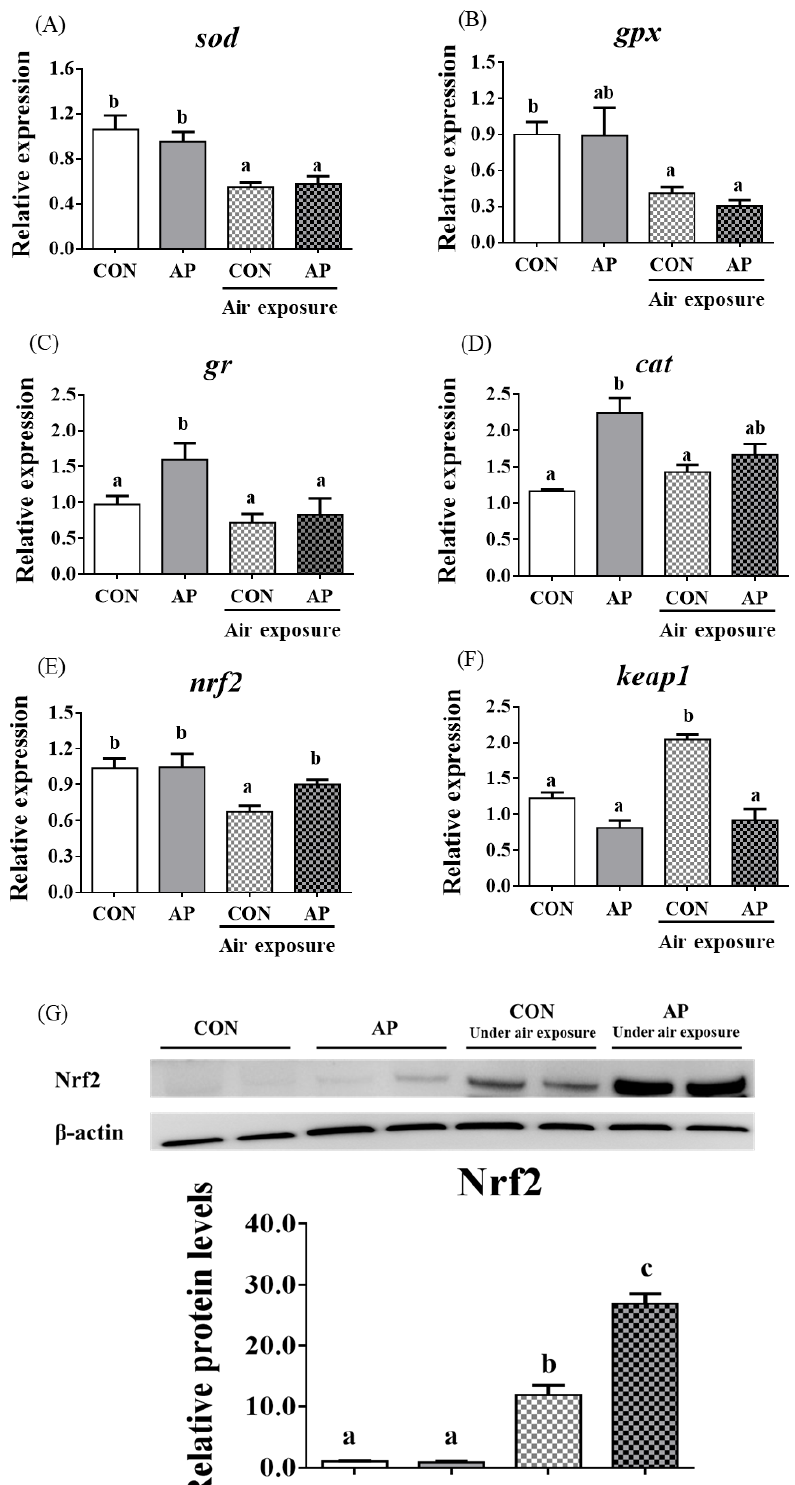
Figure 3. sod ( A ), gpx ( B ), gr ( C ), cat ( D ), nrf2 ( E ), and keap1 ( F ) gene relative expressions levels and Nrf2 ( G ) protein relative expressions level of liver in the two groups before and after air exposure stress. Data are indicated as mean ± SEM ( n = 6). Bars with different lowercase letters mean significant differences among groups ( p < 0.05).